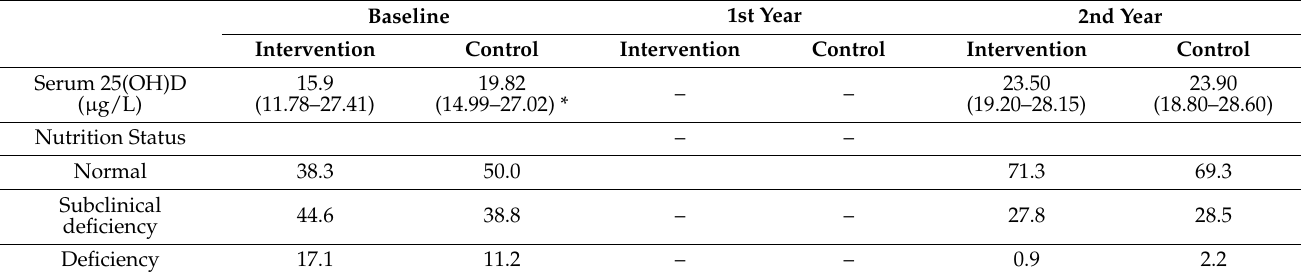
Table 5. Vitamin D deficiency between intervention group and control group at baseline and 2nd year (%) 1